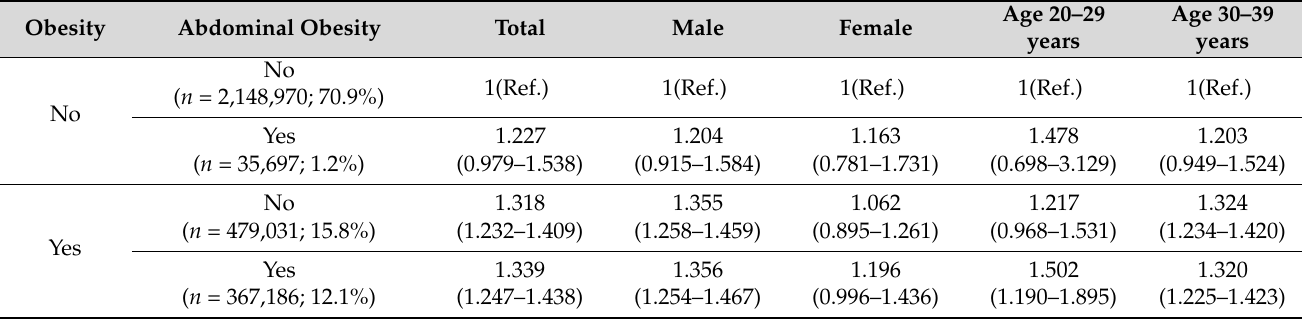
Table 6. Multivariate cox analysis for chronic kidney disease risk by obesity